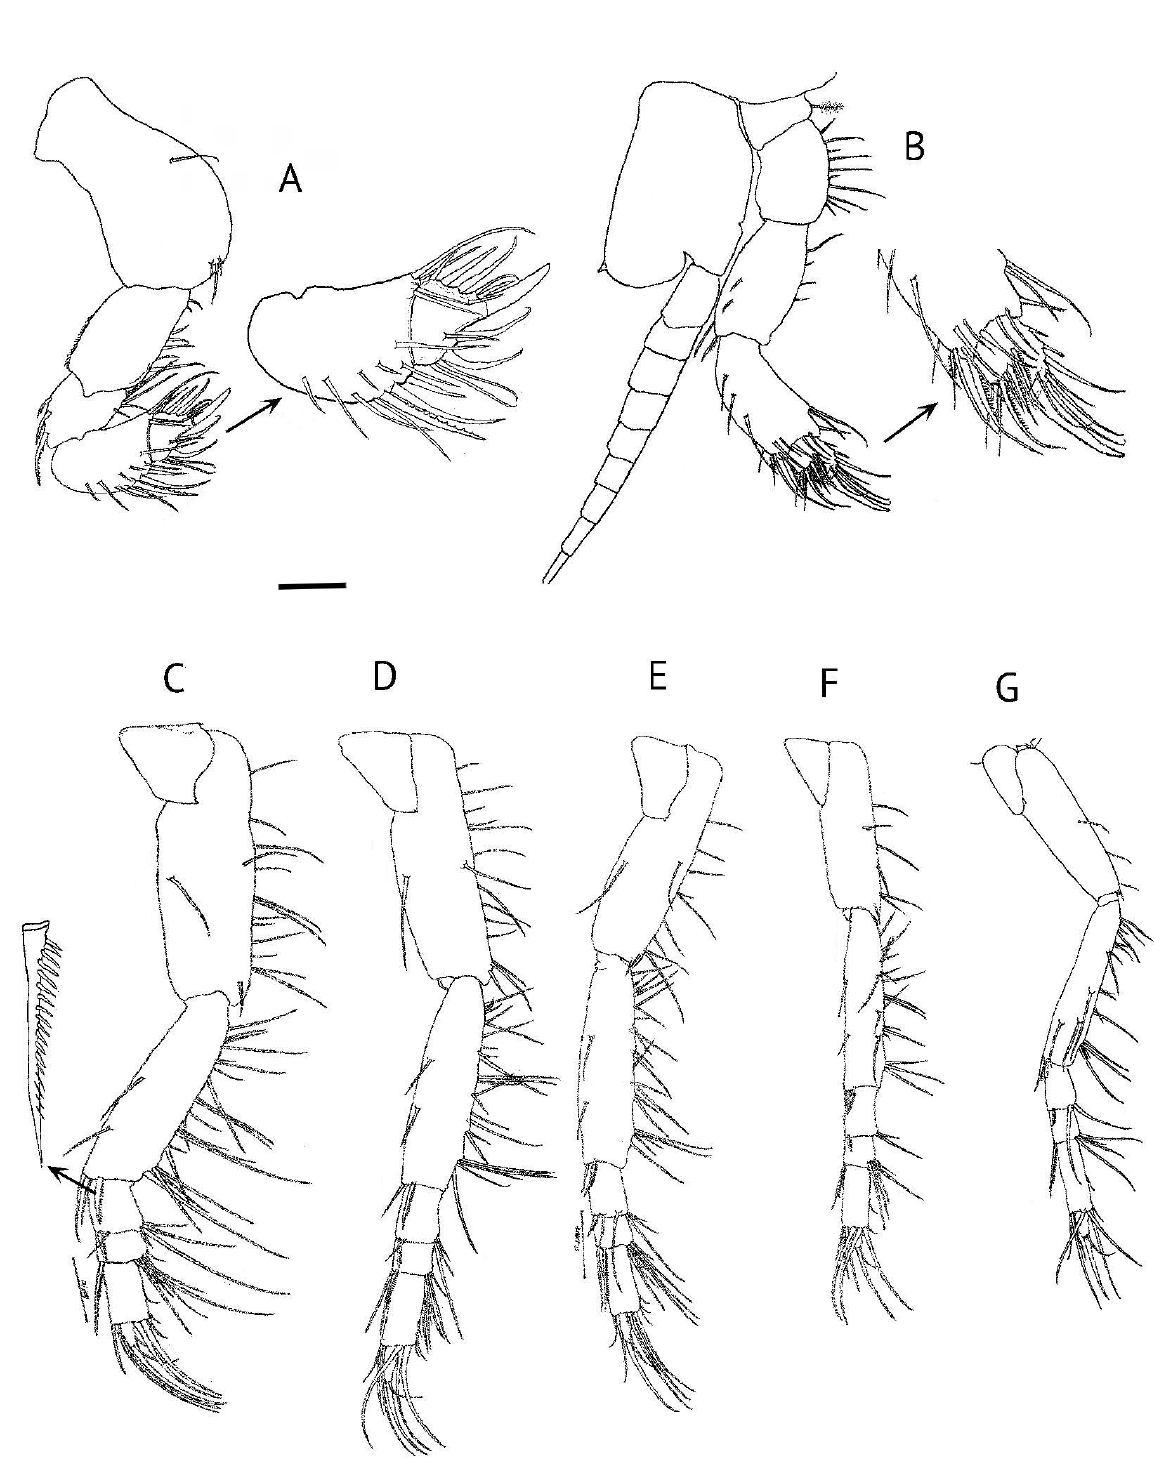
Figure 2. Mysidopsis gemina n. sp., adult female (D, F), male (A–C, E, G). A, thoracic endopod 1 with enlargement of distal end; B, thoracic endopod 2 with enlargement of distal end; C, thoracic endopod 3 with enlargement of serrate seta; D–G, thoracic endopods 4–7. Scale: A–G, 0.1